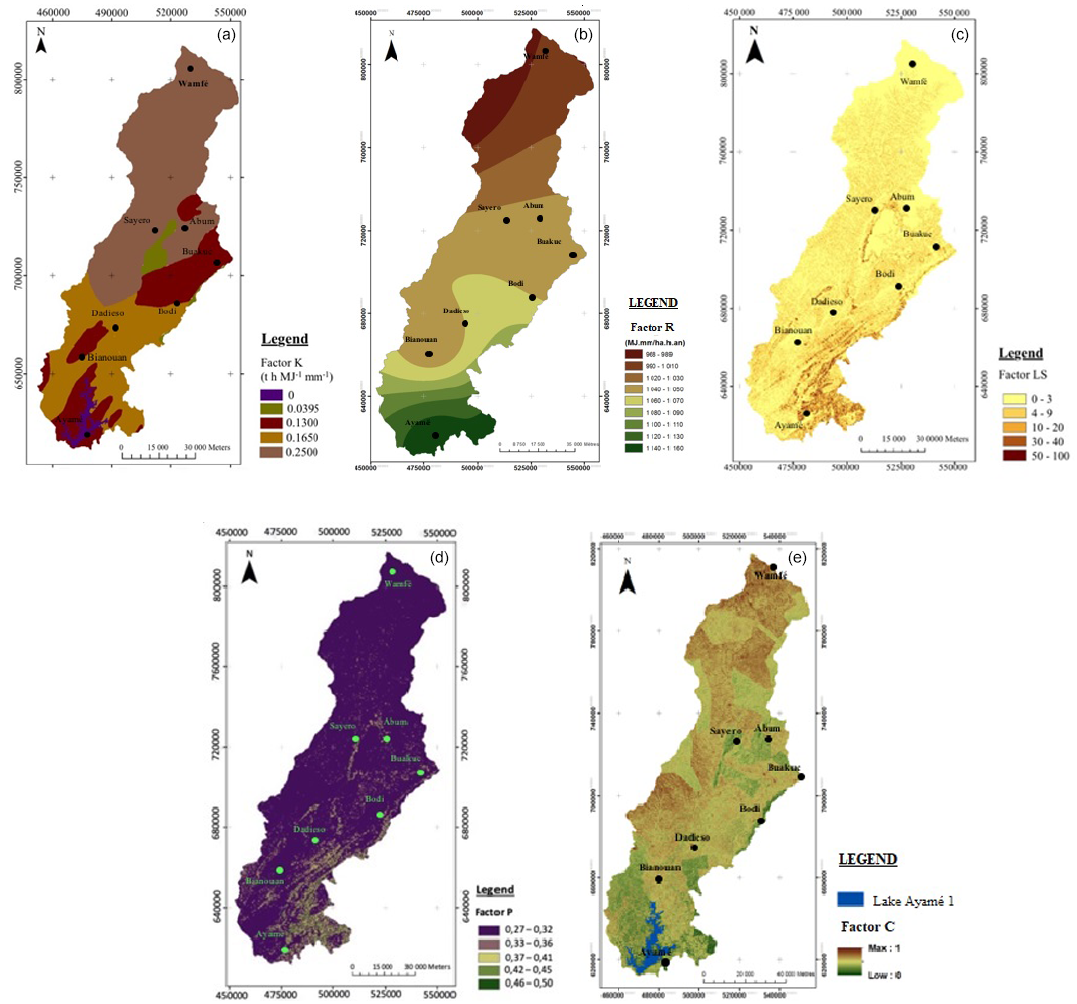
Figure 3. The different erosion factors of the Bia catchment area: (a) Soil erodibility factor K – (b) Rainfall erosivity factor R – (c) Topo- graphical factor LS – (d) Support and conservation practices factor P – (e) Land cover factor C